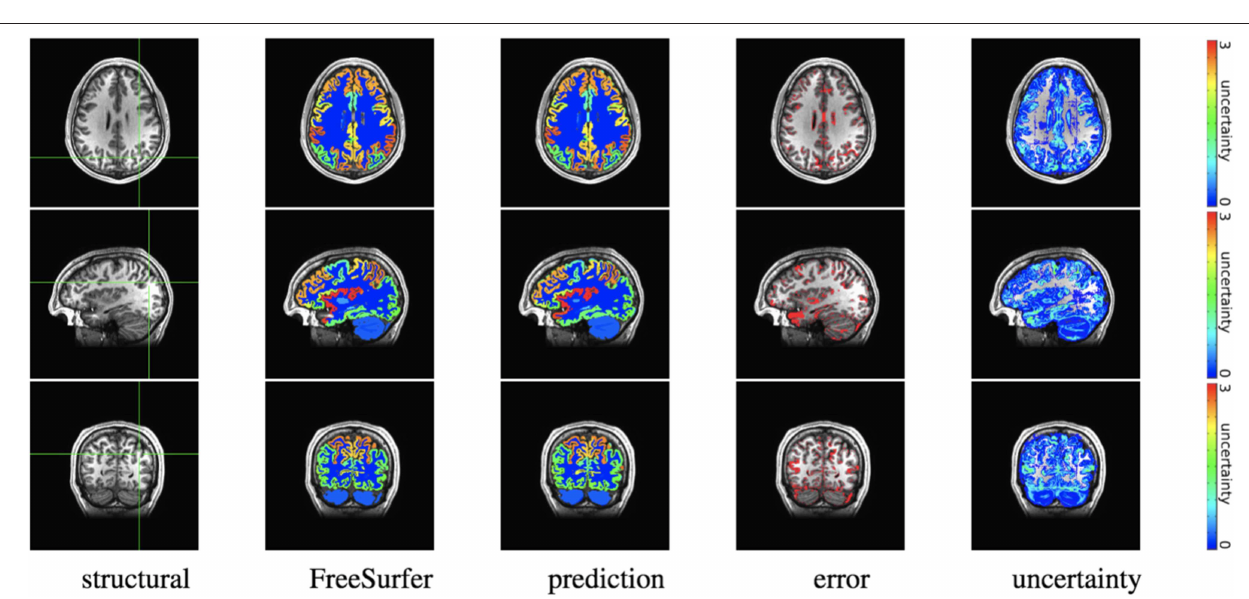
FIGURE 4 | In-site segmentation results for the spike-and-slab dropout (SSD) network for a test subject with average Dice performance. The columns show, respectively, the structural image used as input, the FreeSurfer segmentation used as a prediction target, the prediction made by our network, the voxels where there was a mismatch between prediction and target, and the prediction uncertainty at each voxel.